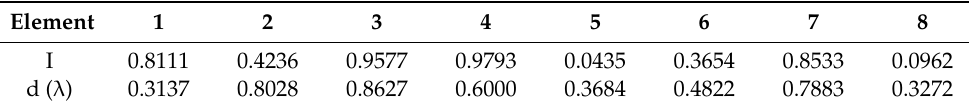
Table 3. Amplitude (I) and element spacing (d) obtained by using AMPA for 8-element CAA PSLL